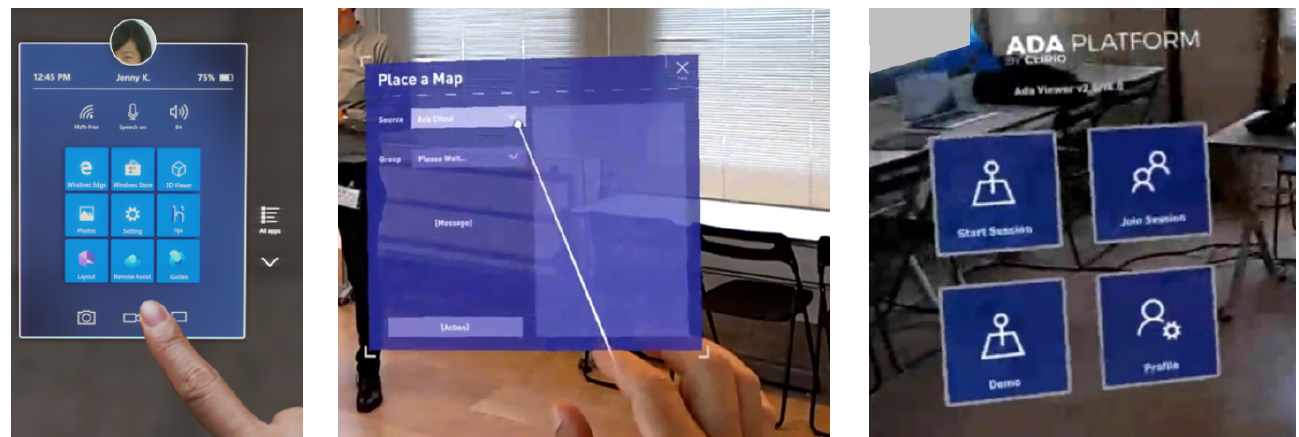
Figure 4. (Left) HoloLens 2 Home menu. The user must tap the desired app/option with their finger, Figure 4. ( Left ) HoloLens 2 Home menu. ( Center ) The user must tap the desired app/option with or “air-tap” from distance with the pointer, as in the image in the centre. (Right) Main menu of the their finger, or “air-tap” from distance with the pointer, as in the image in the centre. ( Right ) Main viewer of the ADA Platform by Clirio. menu of the viewer of the ADA Platform by